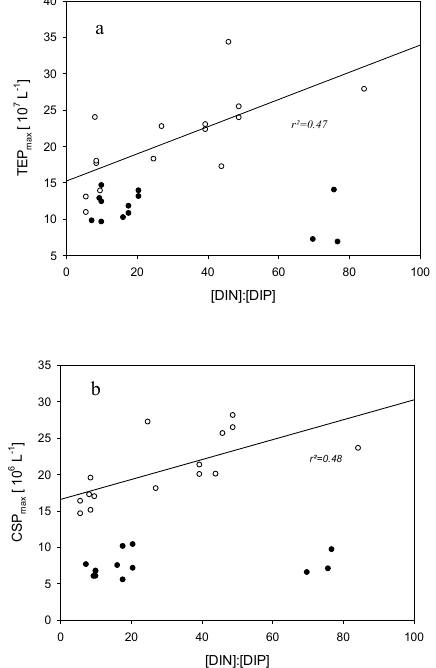
Figure 8. The maximum numerical abundance of TEP (a) and CSP (b) in the mesocosms increased with the initial (day 1) [DIN]:[DIP] ratio during Varied N (open symbols), but not during Varied P (solid symbols).